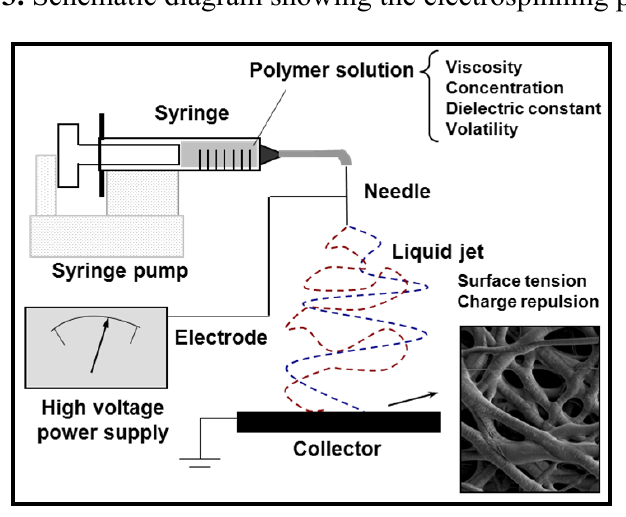
Figure 3. Schematic diagram showing the electrospinning